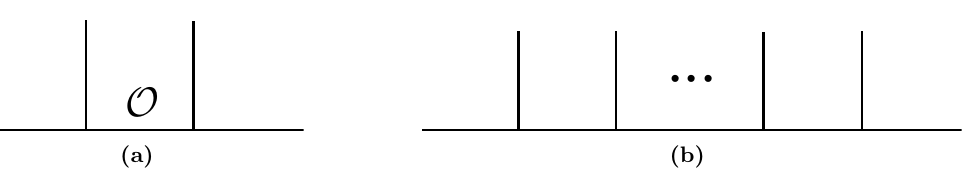
Figure 1. (a) 4-point conformal block. (b) n -point conformal block, in the comb